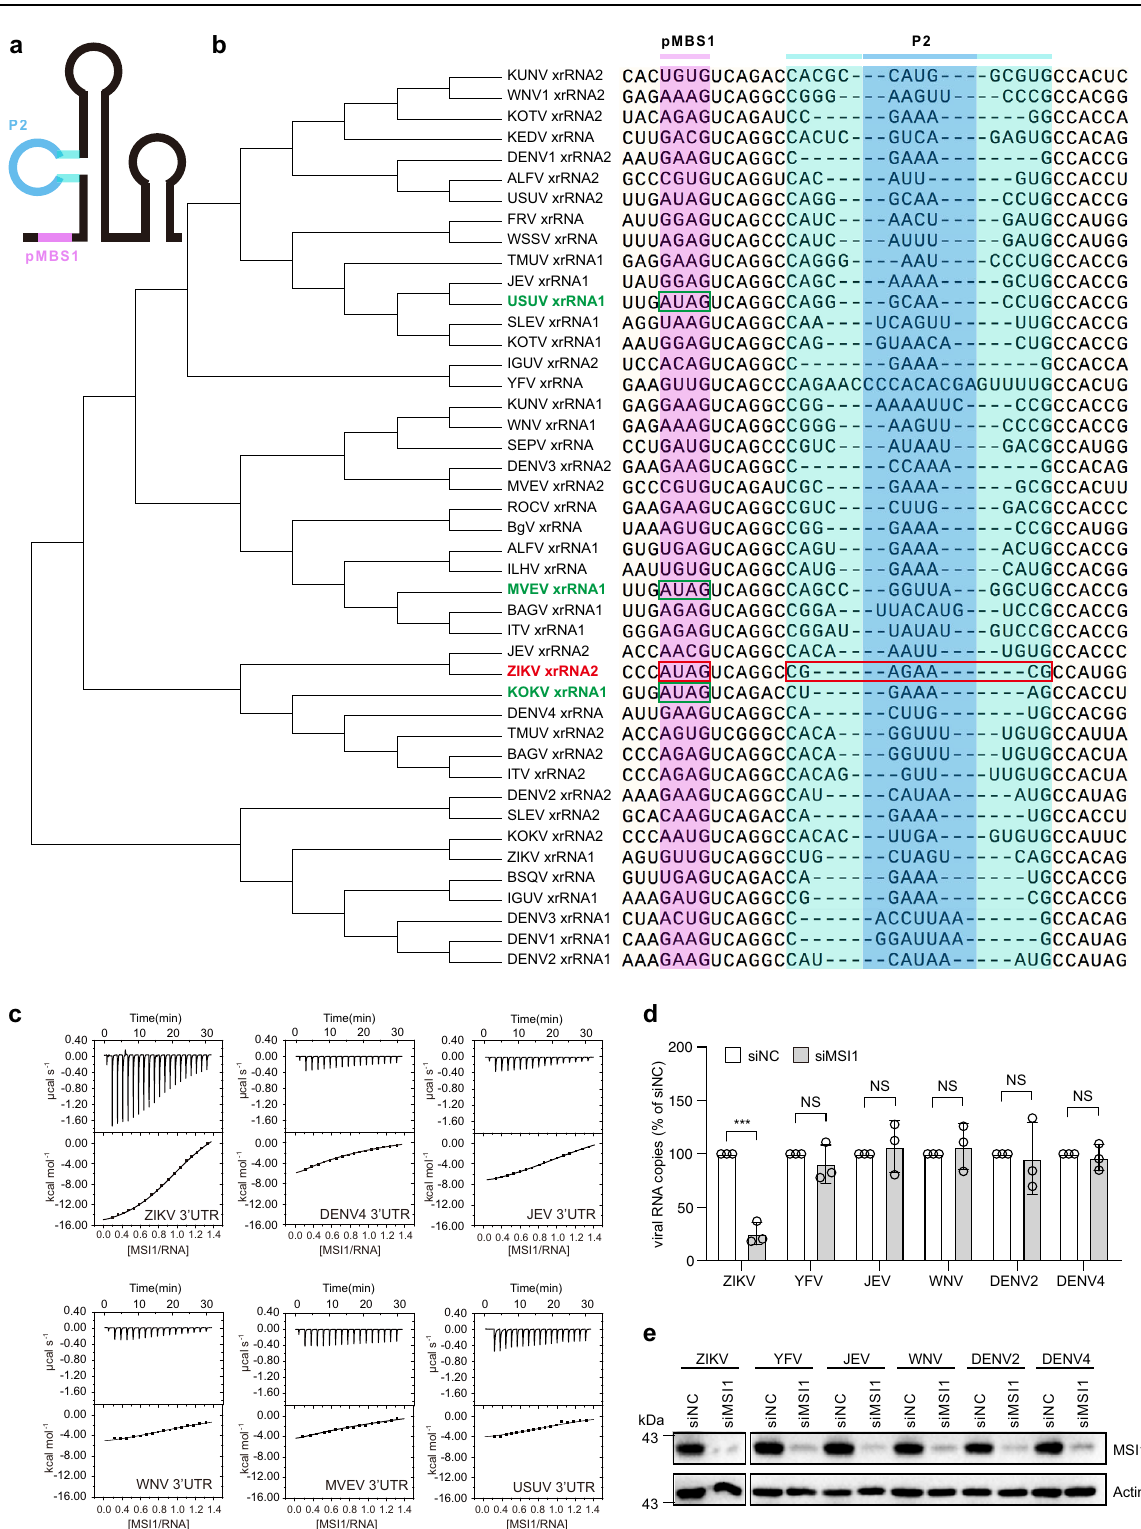
model from cluster 1(Z-score of − 1.64), as shown in Fig. 7f, reveals a bipartite binding mode, which the pMBS1 and P2 AGNN tetraloop of xrRNA2 act like a pincer to speci fi cally target the noncanonical RNA bindinginterfaceinRRM1( α 1and α 2)andloop3connectingthe β 2and β 3 strands in RRM2 of MSI1, respectively. These binding interfaces between xrRNA2 and RRM12 are also compatible with the HDX-MS